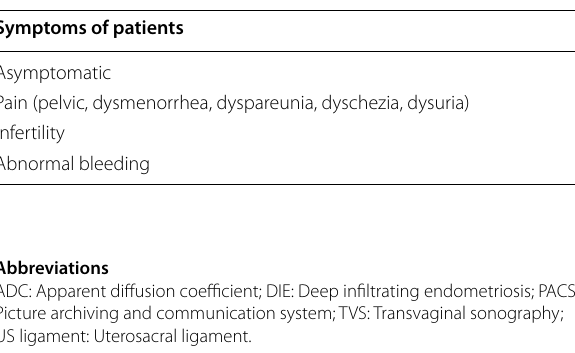
Table 5 Symptoms of patients with endometriosis